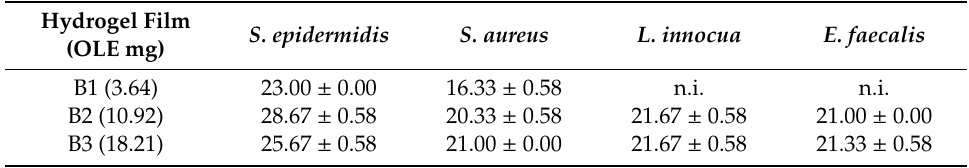
Table 3. Inhibition halos measured for the hydrogel films B1–B3. Results are expressed as mm ± SD ( n = 3, n.i. = no